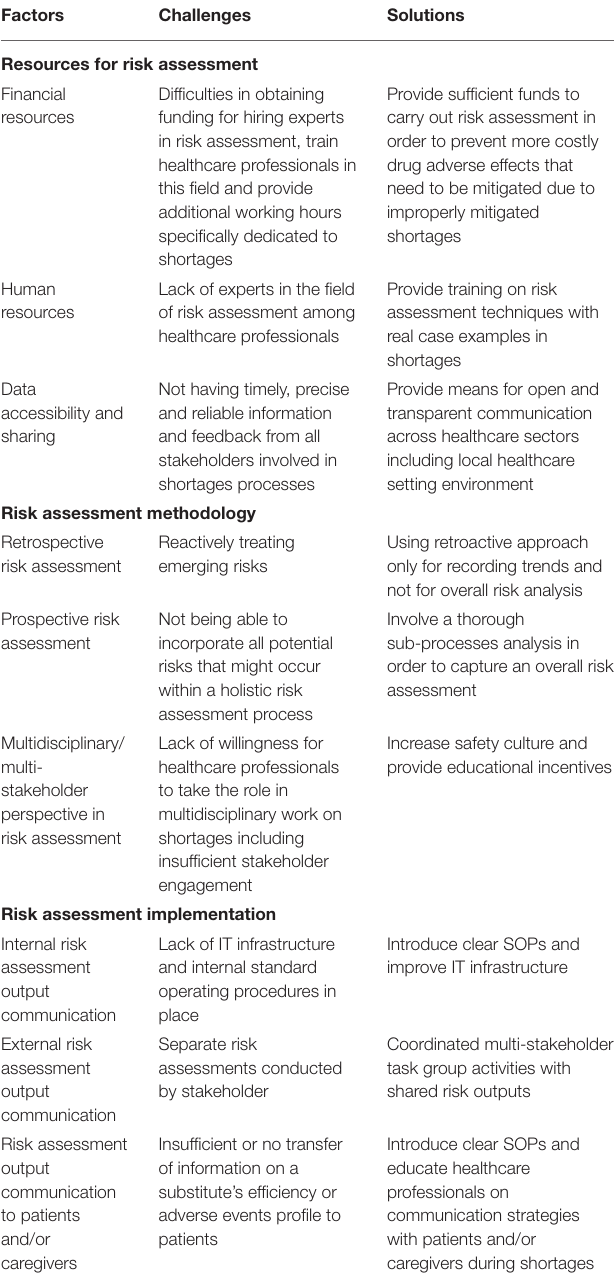
TABLE 2 | Challenges and solutions for overcoming barriers in applying risk assessment in shortages.